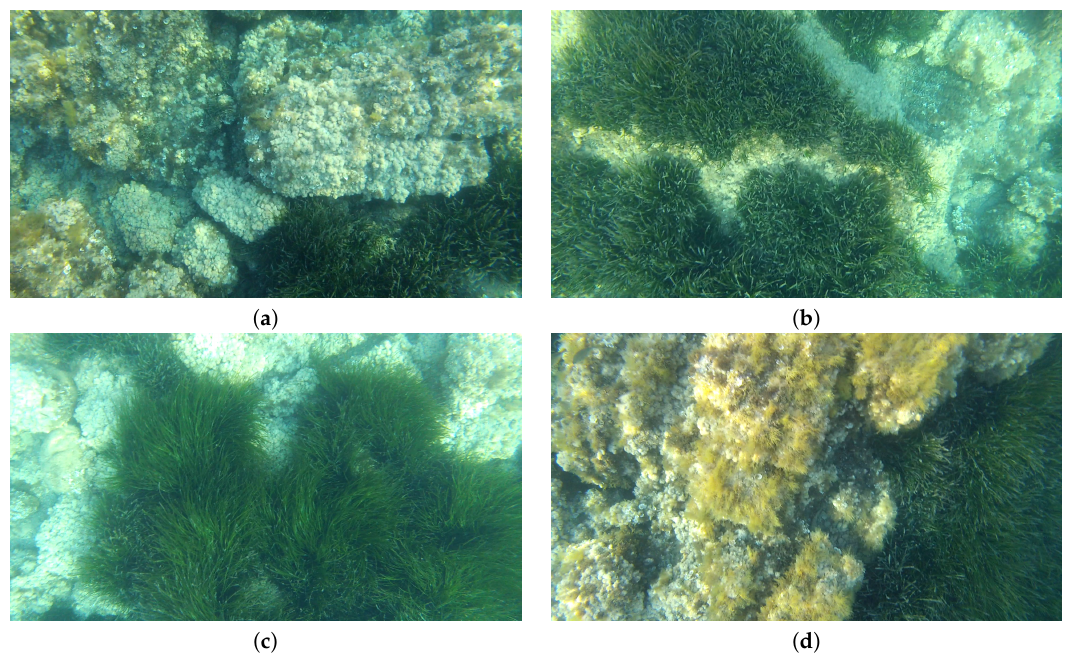
Figure 6. Examples of the images used in the experiments: ( a , b ) session 1 and ( c , d ) session